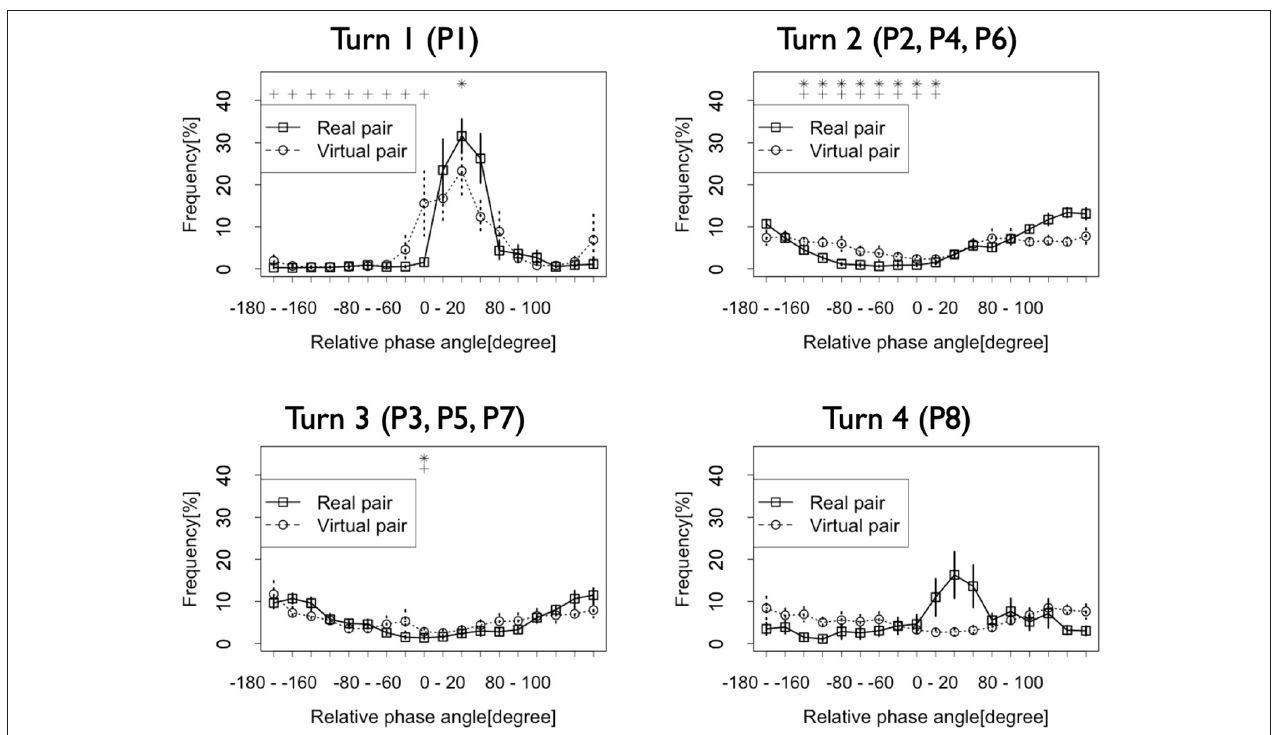
FIGURE 5 | Frequencies of the relative phase of the dancers’ rhythmic movements in each turn. Vertical lines at each plot indicate standard error. Asterisk and cross indicate the relative phases whose frequencies show significant differences with that at − 20–0 degrees and 0–20 degrees in Turn 1 and Turn 4 (*: p < 0.05 with − 20–0 degrees, + : p < 0.05 with 0–20 degrees) and − 180– − 160 degrees and 160–180 degrees in Turn 2 and Turn 3 (*: p < 0.05 with − 180– − 160 degrees, + : p < 0.05 with 160–180 degrees).